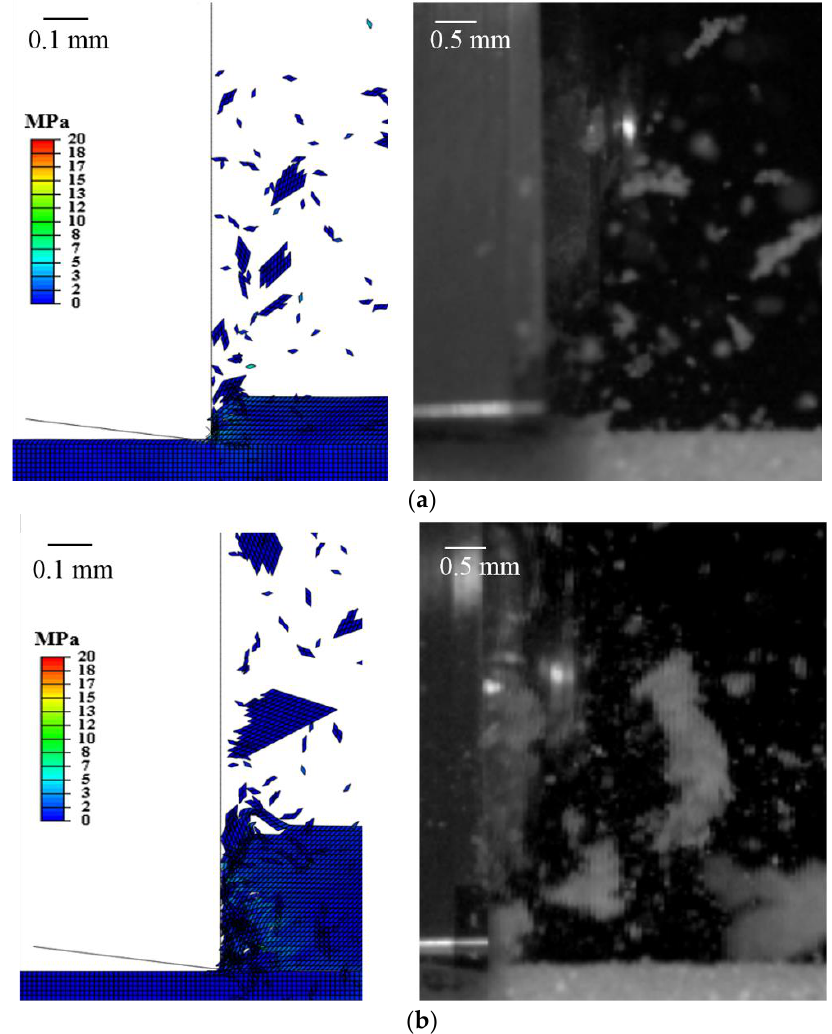
Figure 7. Simulated and experimentally measured chip formation of the 30 pcf with ( a ) depth of cut (DOC) = 0.1 mm and ( b ) DOC = 0.3 mm.